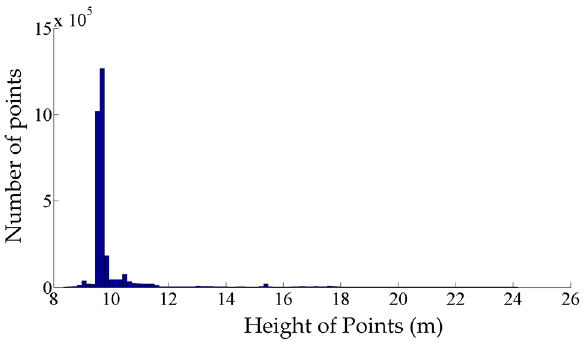
Figure 3. Histogram of points’ height of the entire dataset.